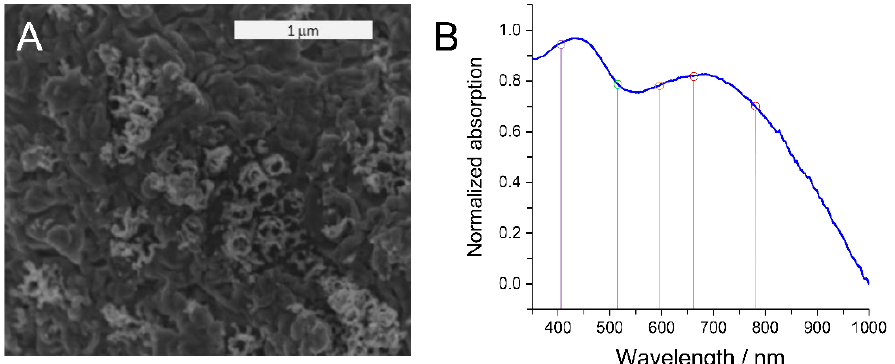
Figure 1. ( A ) SEM image of the TiN electrode created from TiO 2 nanotubes. ( B ) UV-Vis spectrum of the nanostructured TiN electrode. Colored vertical lines indicate the laser excitation wavelengths in the SERS experiments for determination of the corresponding electromagnetic near-field enhancement.